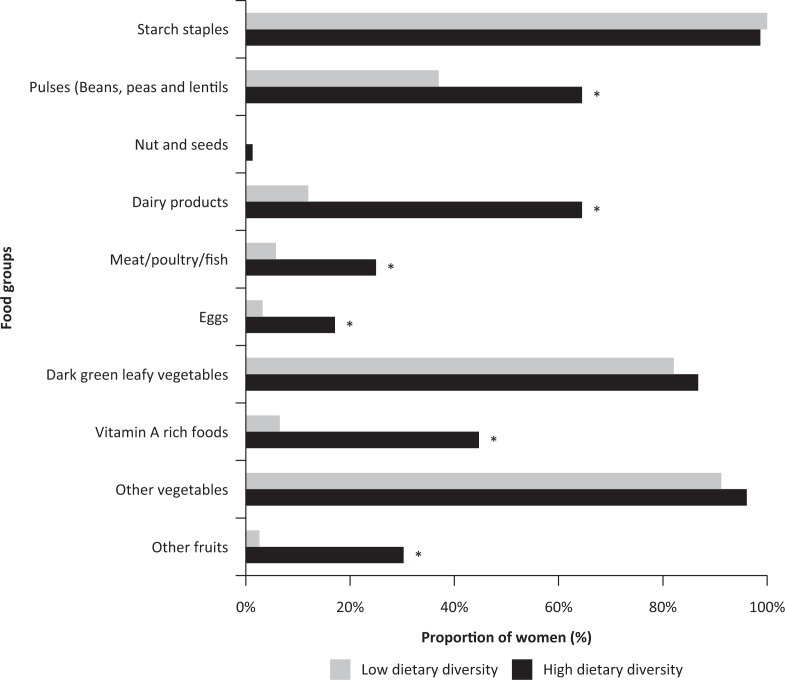
Proportion of women of reproductive age with low versus high dietary diversity score consuming each of the 10 food groups over 24 h. ‘High’ represents those consuming 5 out of 10 food groups (MDD-W) or more [10], whereas ‘low’ represents those consuming 4 food groups or less. *p < 0.05 significant by χ2 test. MDD-W, minimum dietary diversity for women.